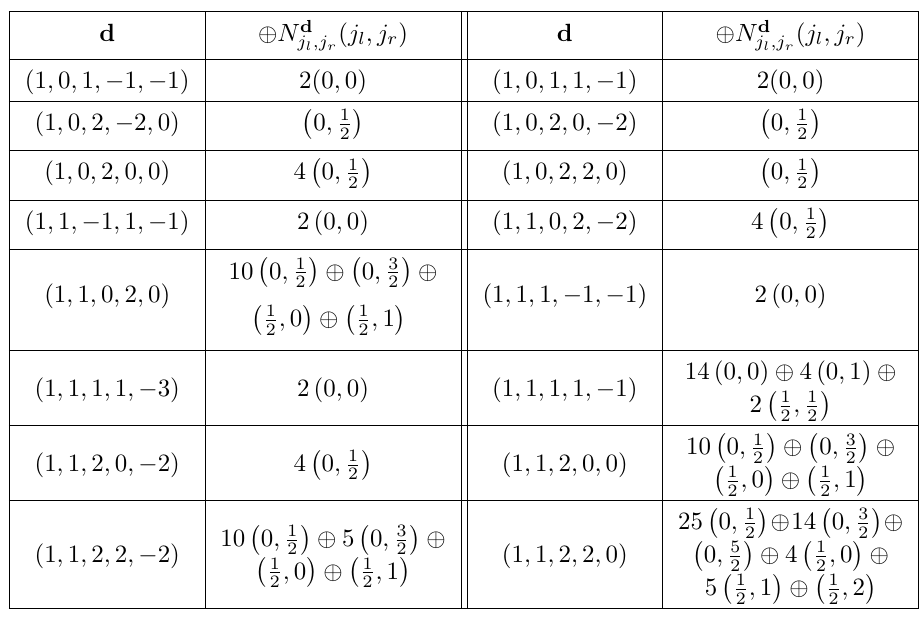
BPS spectrum of the SU(2) × SU(2) theory with 2 bifundamentals. Here, d = ( d 1 , d 2 , d 3 , d 4 , d 5 ) labels the BPS states with charge d 1 m 1 + d 2 m 2 + d 3 φ 1 + d 4 φ 2 + d 5 m i where d 5 counts collective degrees of two bi-fundamental matters with masses m i =3 , 4 . There is a symme- try exchanging ( d 1 , d 2 , d 3 , d 4 , d 5 ) ↔ ( d 2 , d 1 , d 4 , d 3 , d 5 ) and d 5 ↔ − d 5 , so we list BPS states up to ( d 3 , d 4 ) ≤ (2 , 2) and d 5 ≤ 0 for (1 , 0) and (1 , 1)